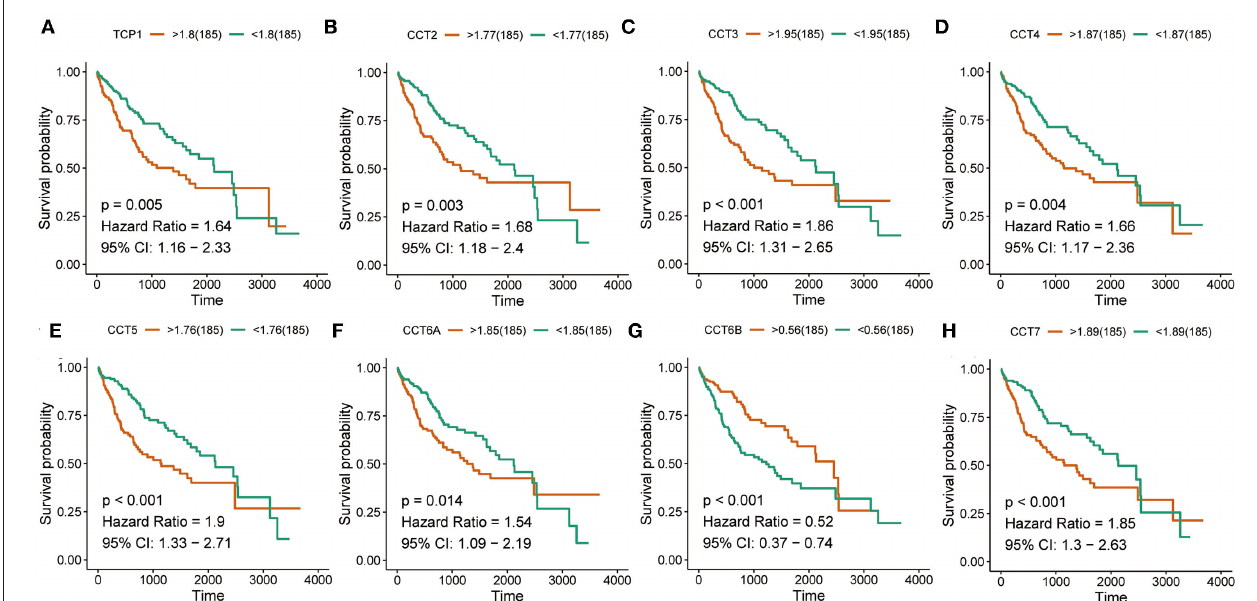
FIGURE 2 | Survival analysis of HCC patients with respect to CCT subunit gene expression. Kaplan-Meier survival analysis was performed in HCC patients from the TCGA cohort. P -value was calculated using log-rank test and is provided at the top left of each figure.